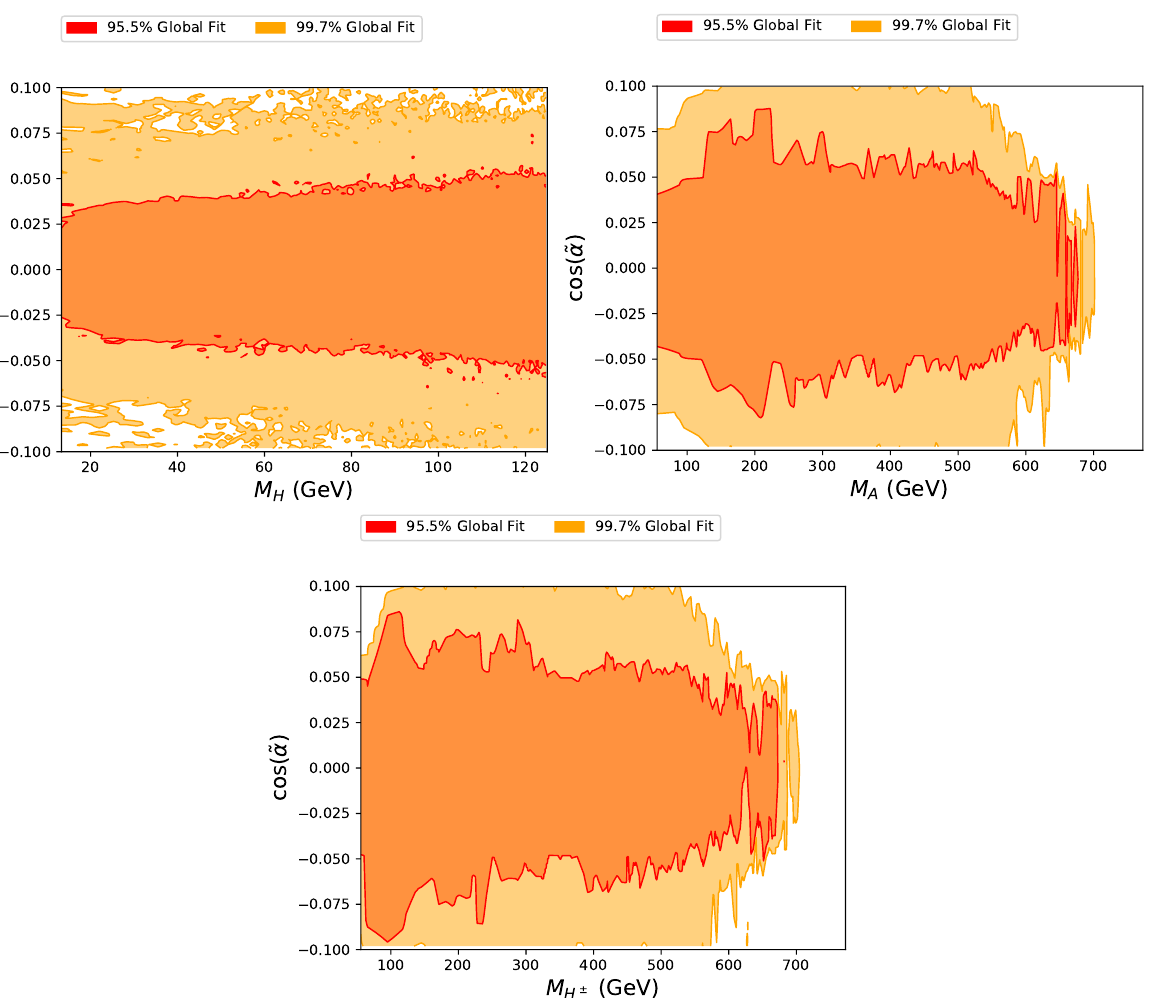
Figure 4. Mixing angle and masses of different additional scalars in the aligned 2HDM, from the scan presented in [24]. For all additional scalars, regions exist where masses are (cid:46) 125GeV, with absolute values of mixing angles such that